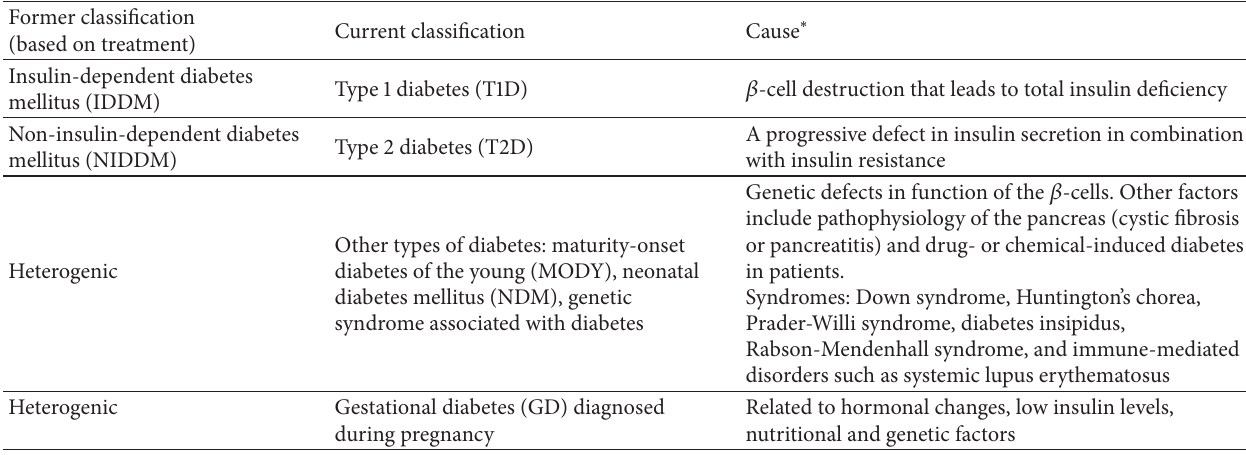
Table 1: Current and former classifications of diabetes